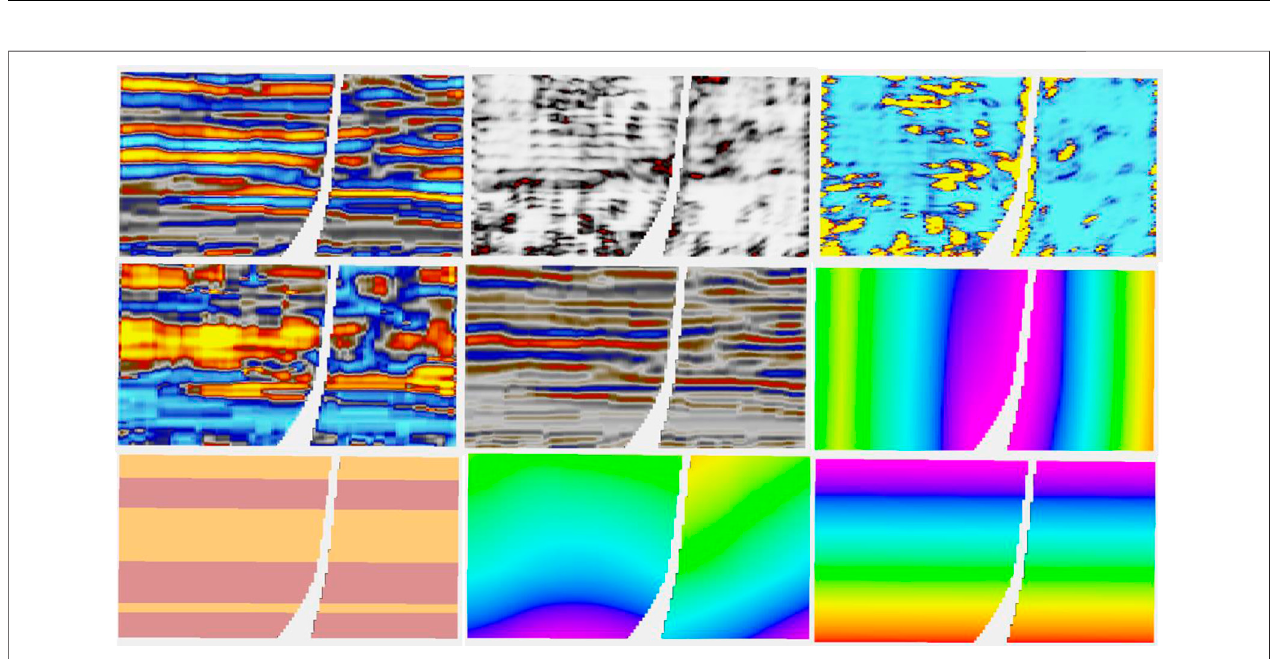
FIGURE 4 | Cross section of nine of thirteen data variables used in modeling. From L to R per row: RAI, chaos, fl atness: sweetness, amplitude, dist. to Fault: depositional zones, TVD, and strat. depth.